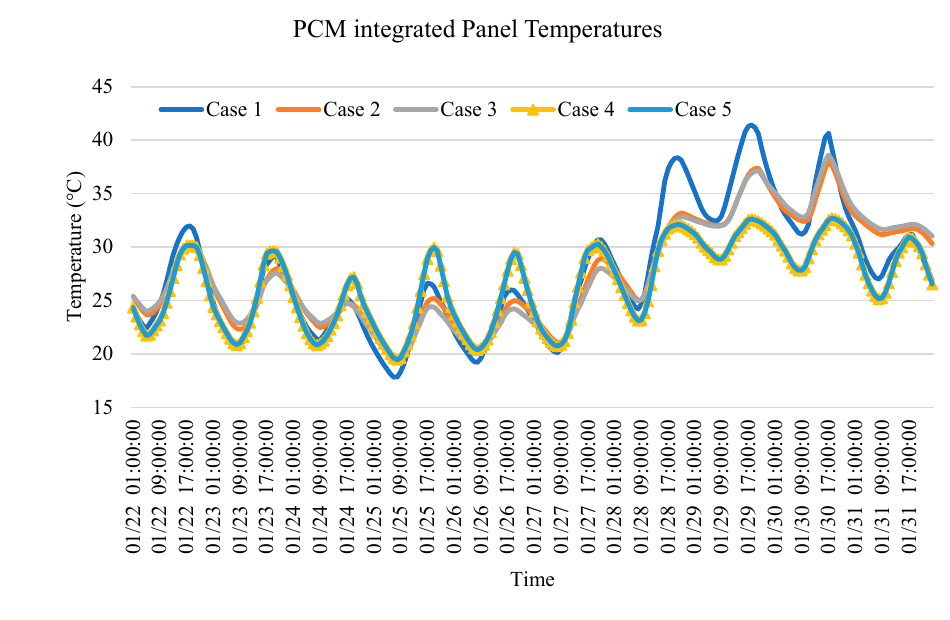
Figure 14. Charging and discharging of TESP layer.